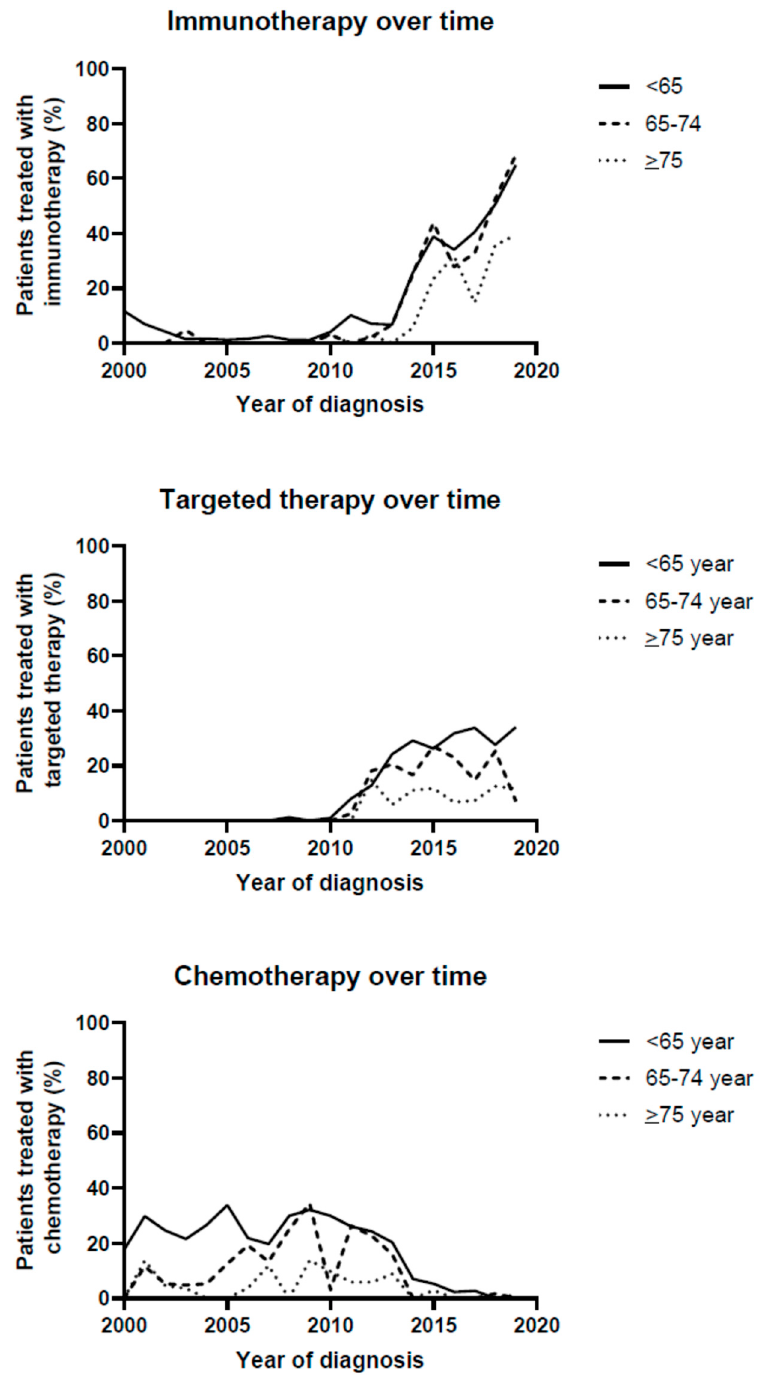
Figure 1. Treatment strategies over time.